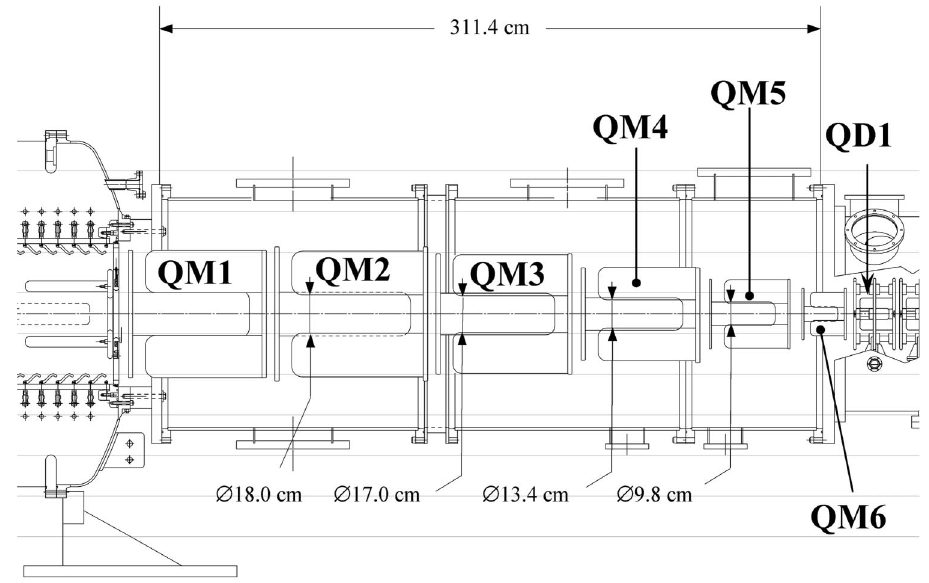
FIG. 4. Mechanical drawing (elevation view) of the matching section. On the left is the injector. On the right is the first quadrupole of the transport section (QD1) which is movable to allow room for diagnostics.